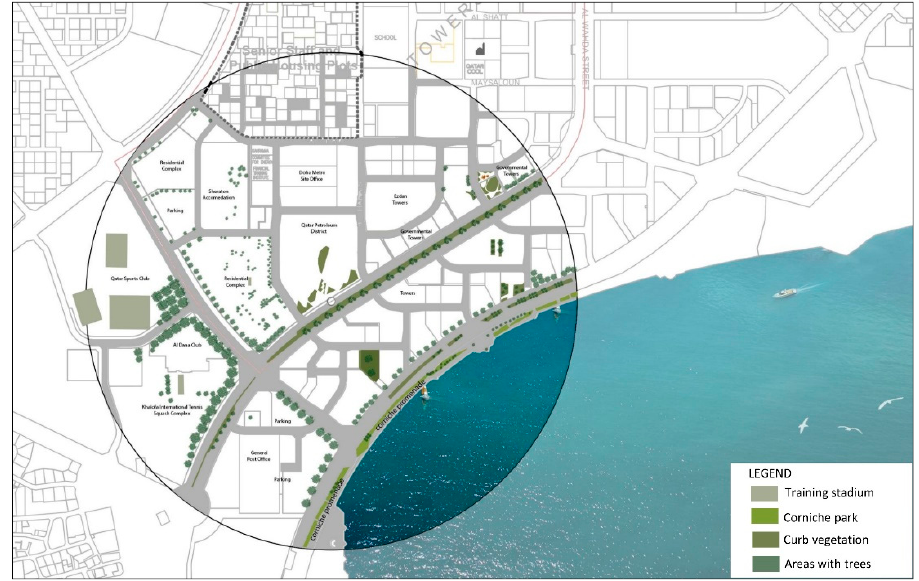
Figure 15. Characteristics of the vegetation at the study site, categorized in relation to ground use balance (Source: the Authors).